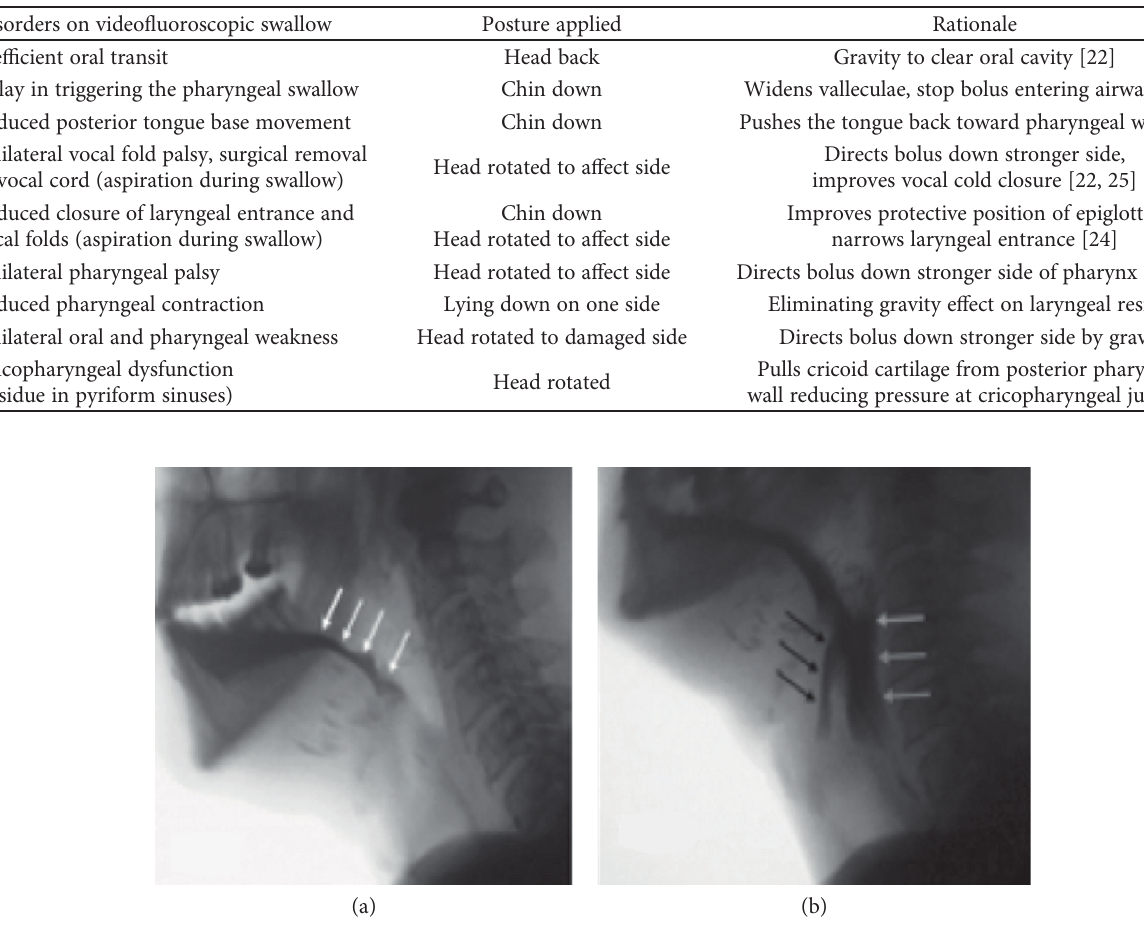
Figure 1: Lateral fl uoroscopic view of a 49-year-old man who has undergone a near-total glossectomy for advanced head and neck cancer. A small amount of tongue is seen. The patient has poor oral bolus control and early loss into the oropharynx ((a) white arrows). He has lost his ability to pull the hyoid and the larynx up and forward to open the upper esophageal sphincter resulting in pharyngeal dysphagia and food remaining in pharynx (white arrows) with penetration just over arytenoid complex, remaining above the vocal folds (black arrows). This represents a penetration and aspiration score of 3